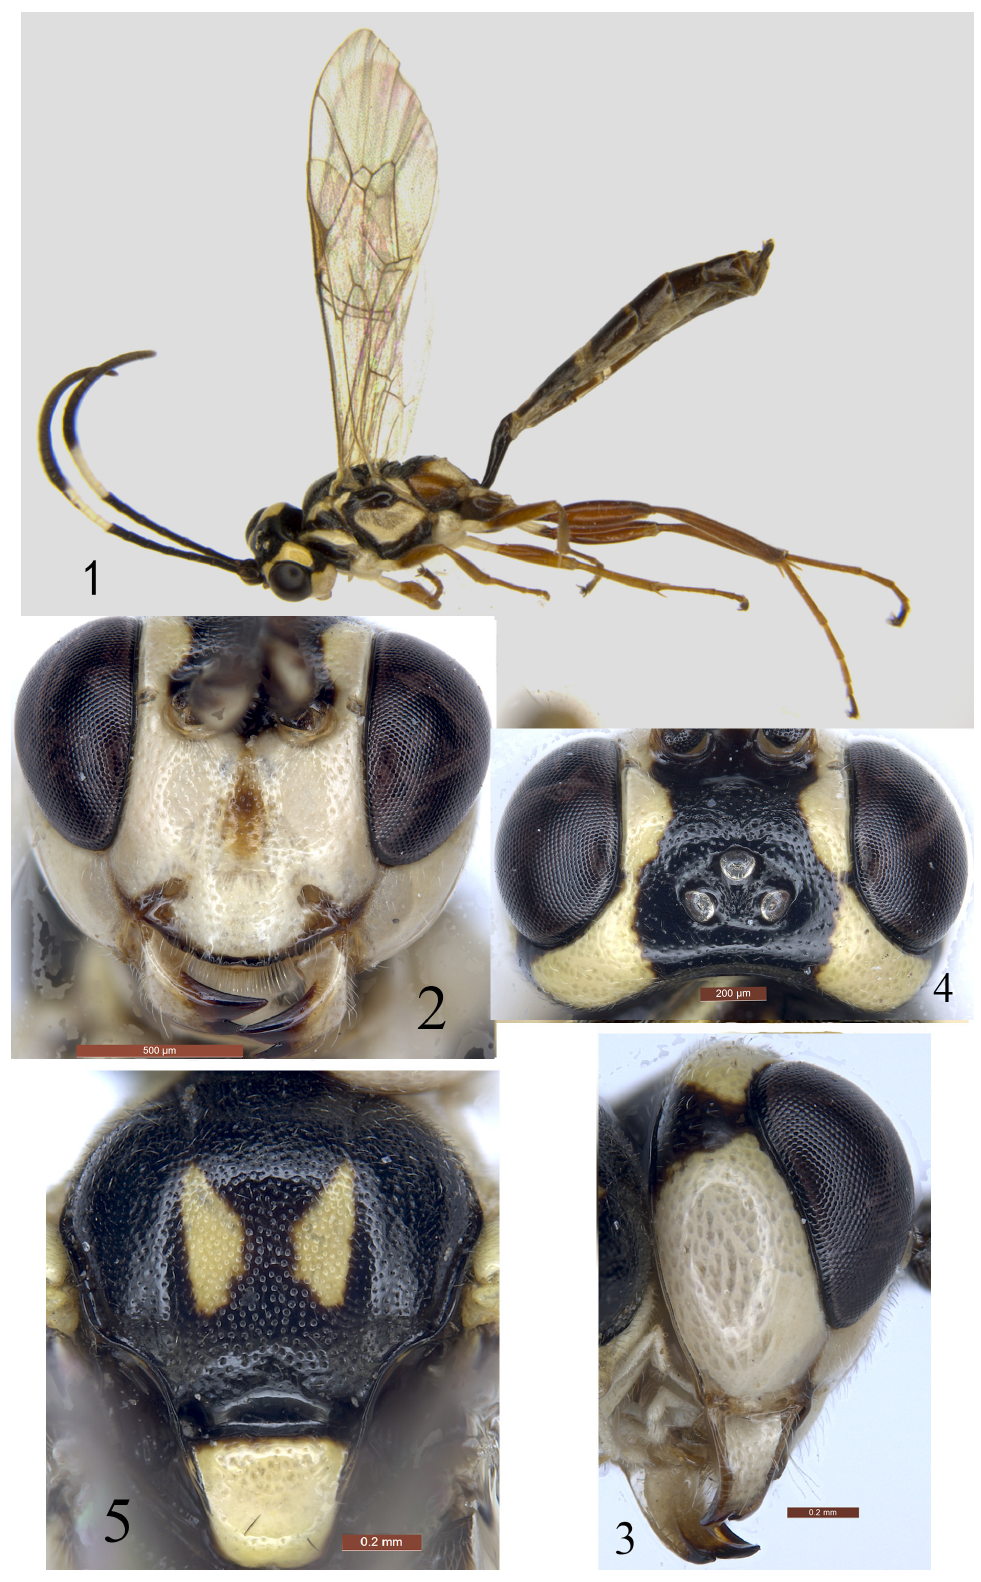
Figs 1–5. Notosemus albimaculatus Sheng & Sun, sp. nov., holotype, ♀ 1 . habitus, lateral view. 2 . head, anterior view. 3 . head, lateral view. 4 . head, dorsal view. 5 . Mesoscutum and